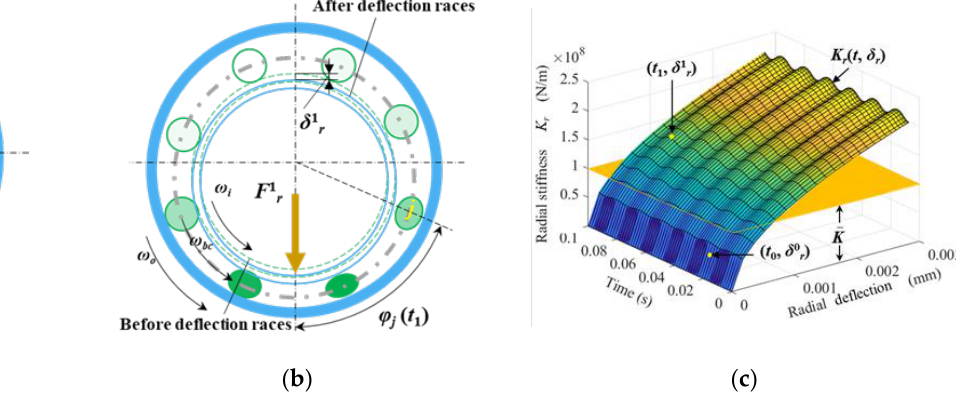
Figure 4. Schematic diagram of the ball bearing with time-varying loads and rotating speed: ( a ) at time t 0 , ( b ) at time t 1 , and ( c ) comparison between real nonlinear stiffness and linear constant stiffness.